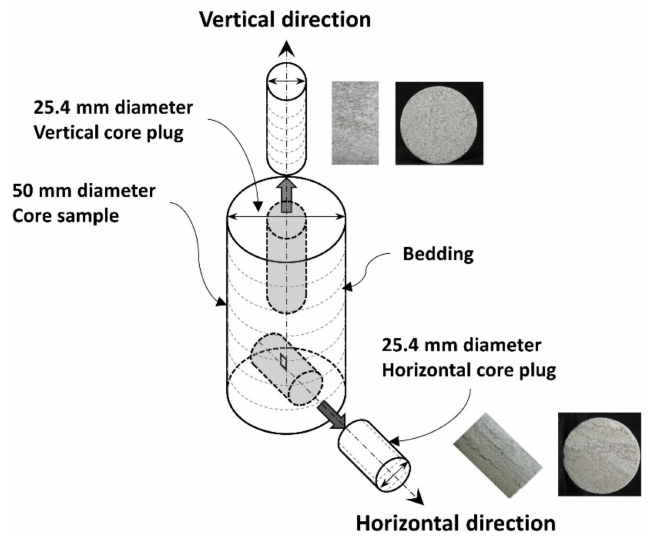
Figure 2. Schematic diagram of directional core